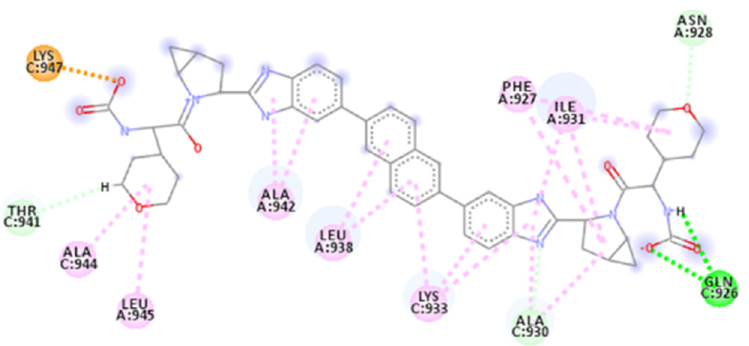
Figure 9. Calculated 2D interactions of PubChem-66982178 in complex with SARS-CoV-2’s HR1 do- main.